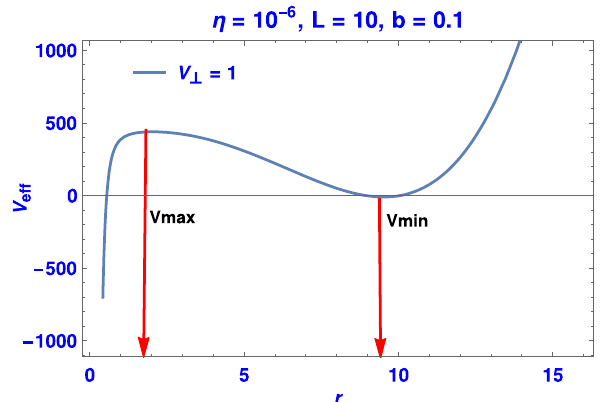
Fig. 4 Here we plotted the effective potential against r . The local min- imum ( V min ) and maximum ( V max ) are corresponds to ISCO and unsta- ble orbits,